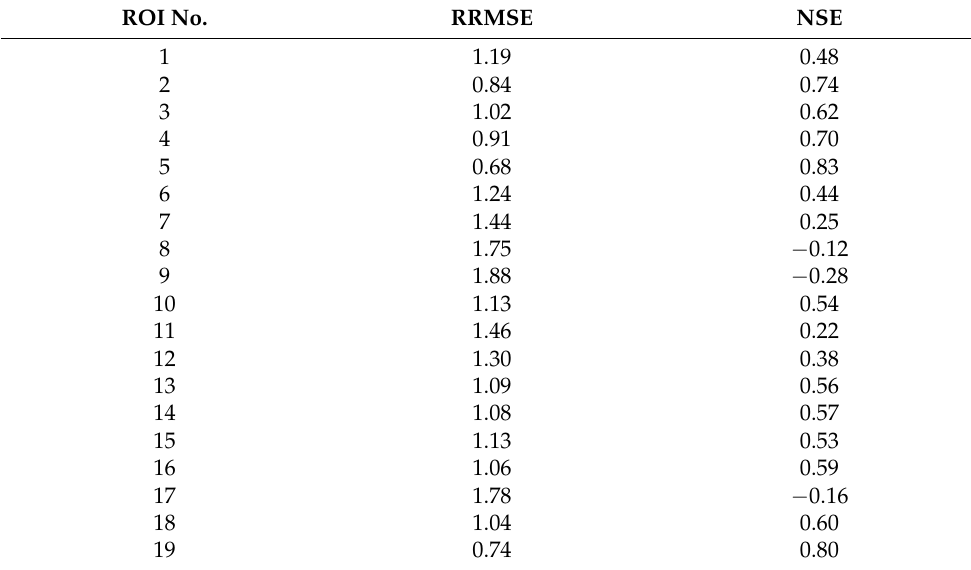
Table 6. The accuracy of discharge estimation of 19 selected ROIs. ROI No.